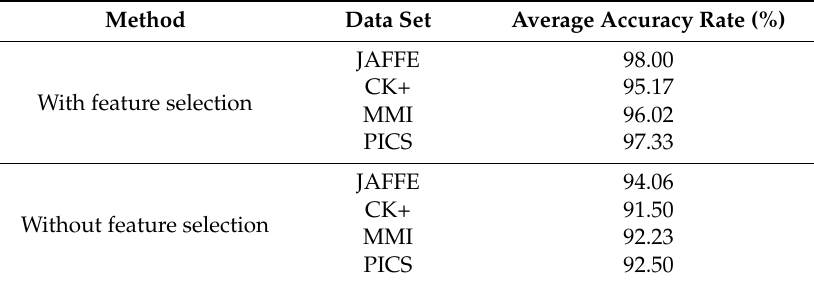
Table 1. Comparison of average accuracy rate of the proposed method with and without feature selection on the four data sets.